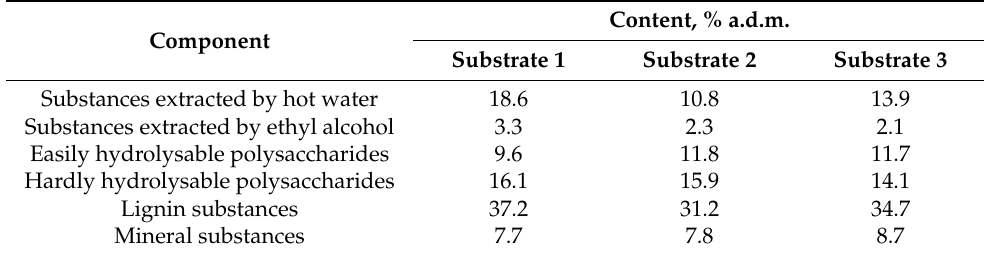
Table 3. Componential composition of the biodestroyed